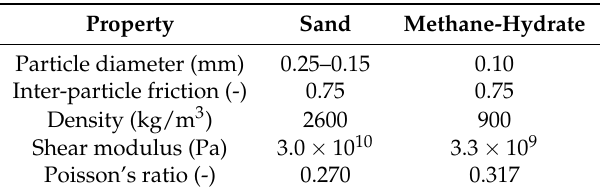
Table 1. Material